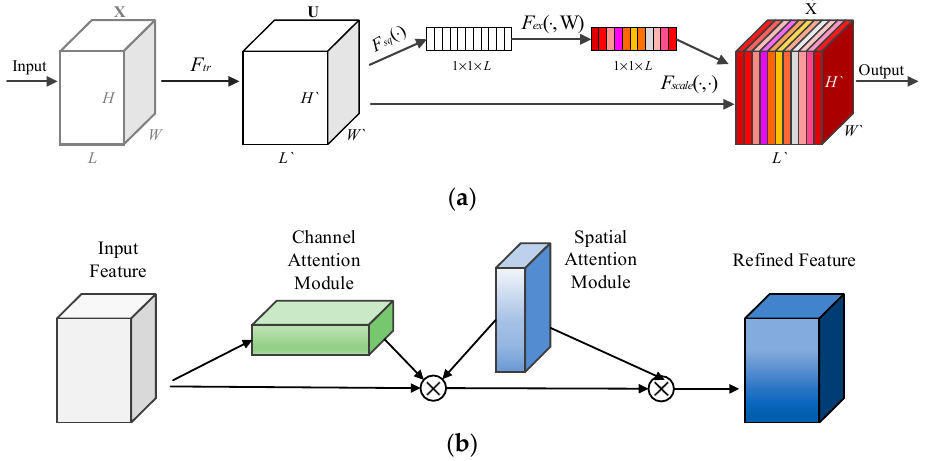
Figure 5. Schematic diagram of the principles of the two attentional mechanisms. ( a ) SE Net structure diagram. (This image was provided by Dr. Hu Jie of Momenta); ( b ) CBAM structure diagram. (This image was provided by Dr. Woo Sanghyun and Prof. Kweon In So of Korea Adv Inst Sci and Technol).